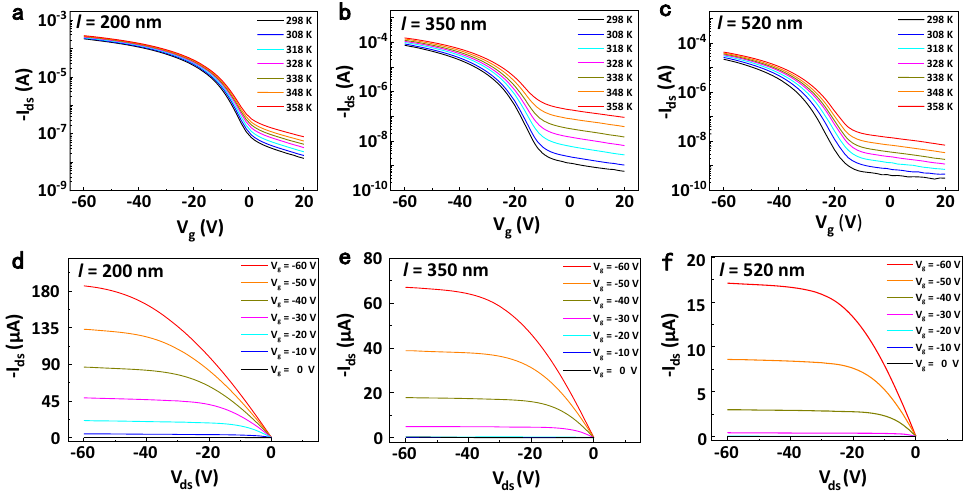
Fig. 2 The characteristic curves of the DNTT OFETs with different grain sizes. a – c The temperature dependent transfer curves of OFETs with grain sizes of about 200 nm, 350 nm and 520 nm. V ds = − 60 V. d – f The output curves of OFETs with different DNTT grain sizes corresponding ( a – c ). The character l in all fi gures denotes grain size. All electrical measurements were performed in dark ambient unless otherwise speci fi ed.